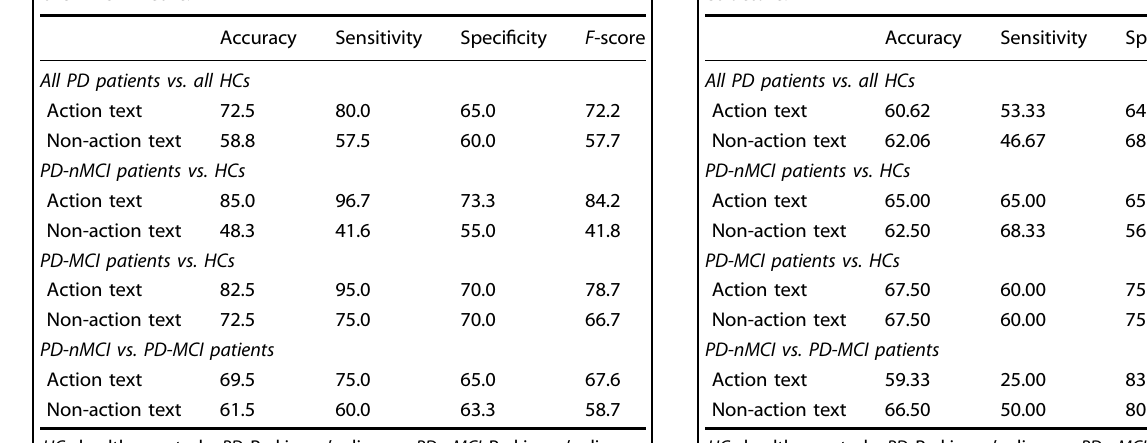
Table 1. Machine learning results for each group tandem based on the P-RSF metric.